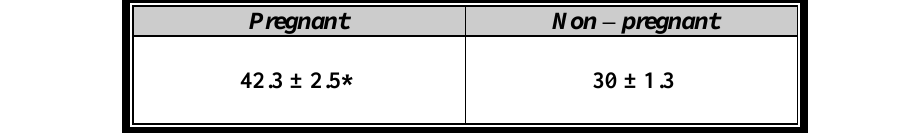
Table (1) The effect of pregnancy on MDA concentration . (nanomol / Liter) .